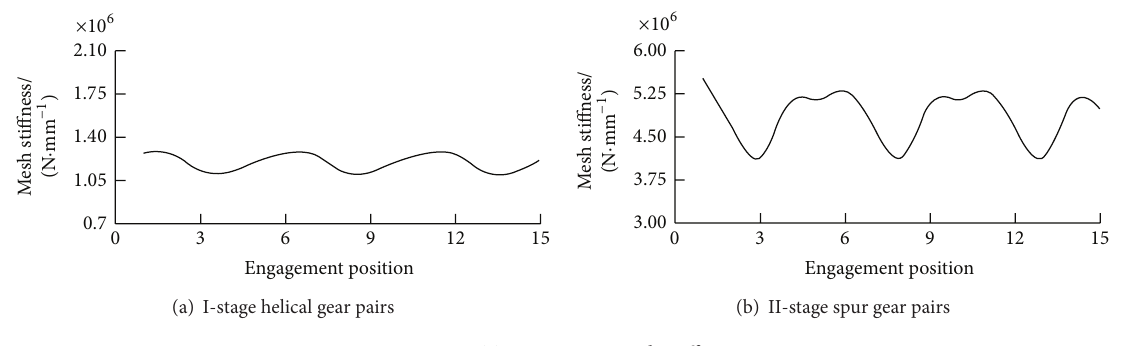
Figure 13: Time-varying mesh stiffness.